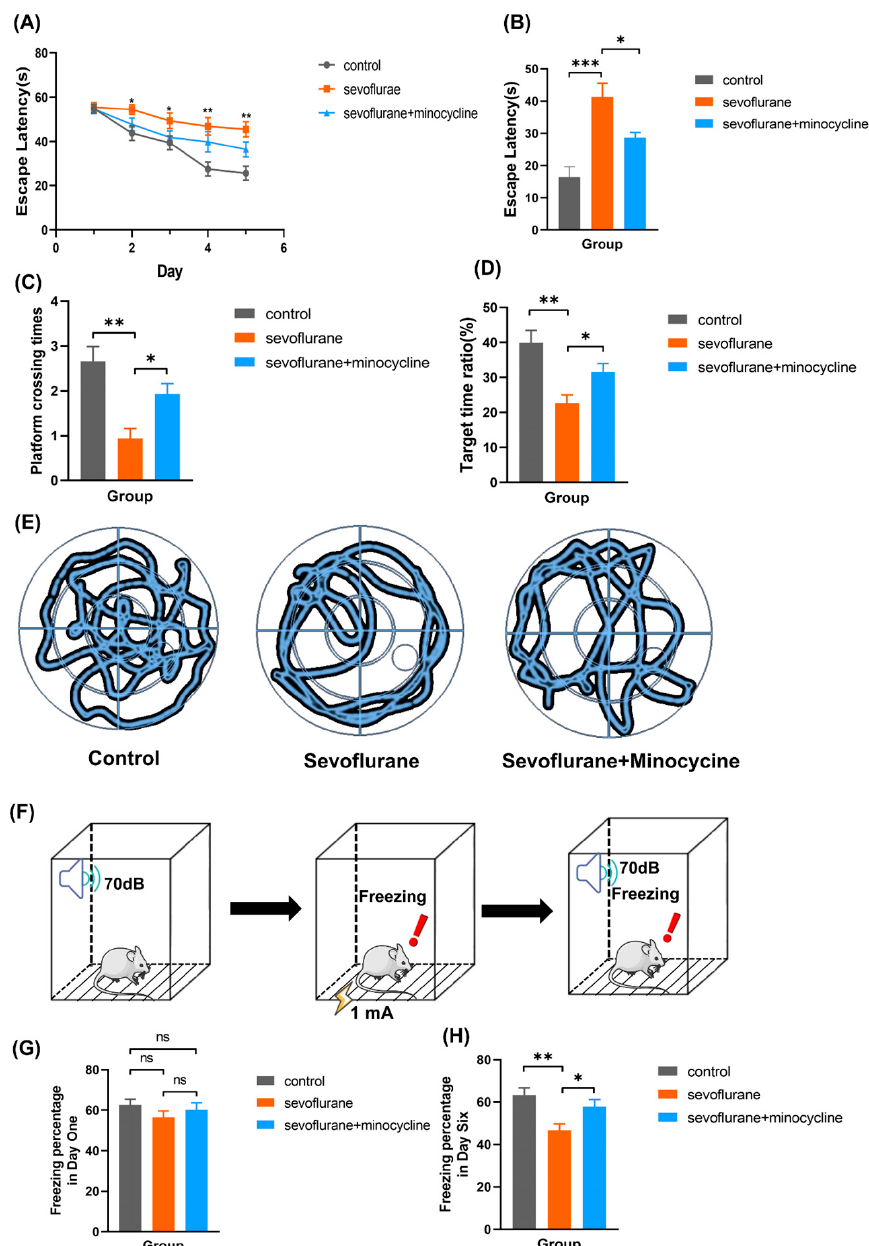
Figure 1. Minocycline alleviates learning and memory impairments associated with sevoflurane: ( A ) Escape latency (time required to find the platform) during the MWM training on days 1–5; ( B ) Escape latency in the space exploration experiment; ( C ) Platform crossing times during the space exploration test; ( D ) Target time ratio during the space exploration experiment; ( E ) Typical swimming track in each group; ( F ) Schematic diagram of the fear conditioning test; ( G ) Freezing percentage on day 1; ( H ) Freezing percentage on day 6. Data are mean ± SEM ( n = 10). ns, no significance; * p < 0.05, ** p < 0.01, *** p < 0.001.